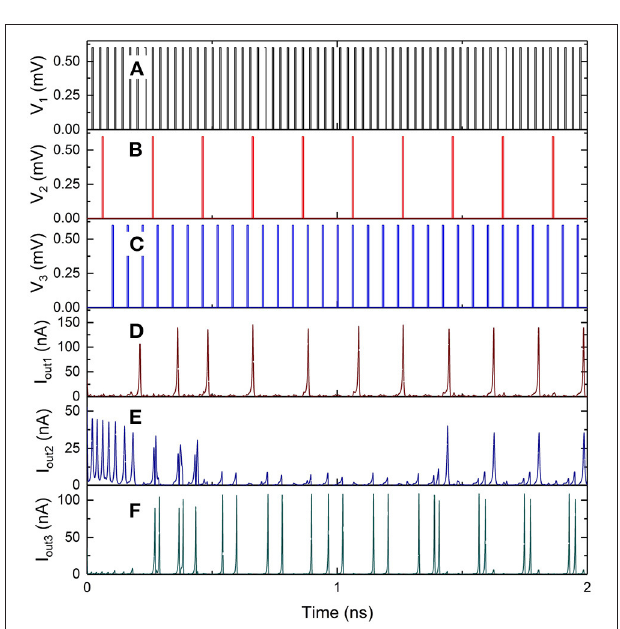
FIGURE 13 | Simulation results of the 3 × 3 coupled synapse network shown in Figure 12 . (A) Input voltage pulses of 0.6 mV with time period of 60 ps at V 1 . (B) Input voltage pulses of 0.6 mV with time period of 200 ps at V 2 . (C) Input voltage pulses 0f 0.6 mV with time period of 30 ps at V 3 . (D) Spiking current output at I out1 . (E) Spiking current output at I out2 . (F) Spiking current output at I out3 .